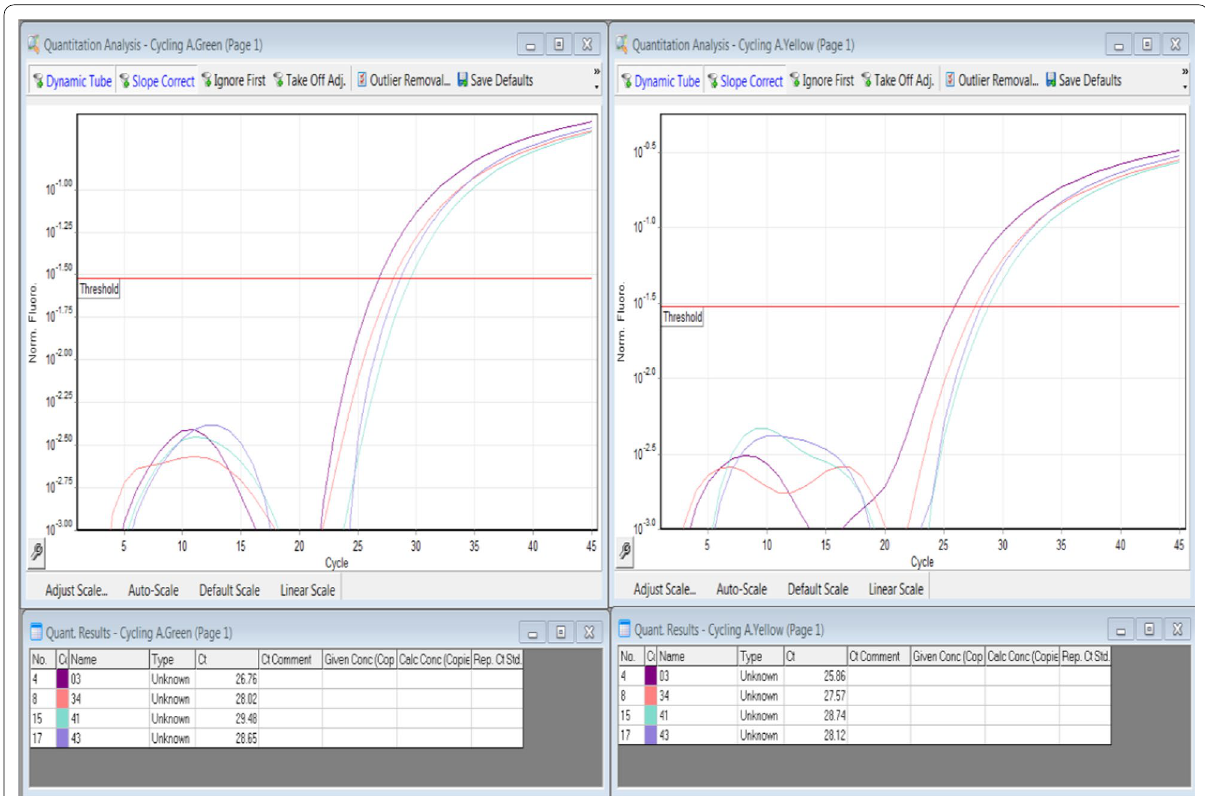
Fig. 1 AML cases with high normalized METTL3 expression (high 2 − ΔΔCT formula): the left side showing FAM ™ ( METTL3 target gene CT), the right‑side VIC (Beta actin reference gene